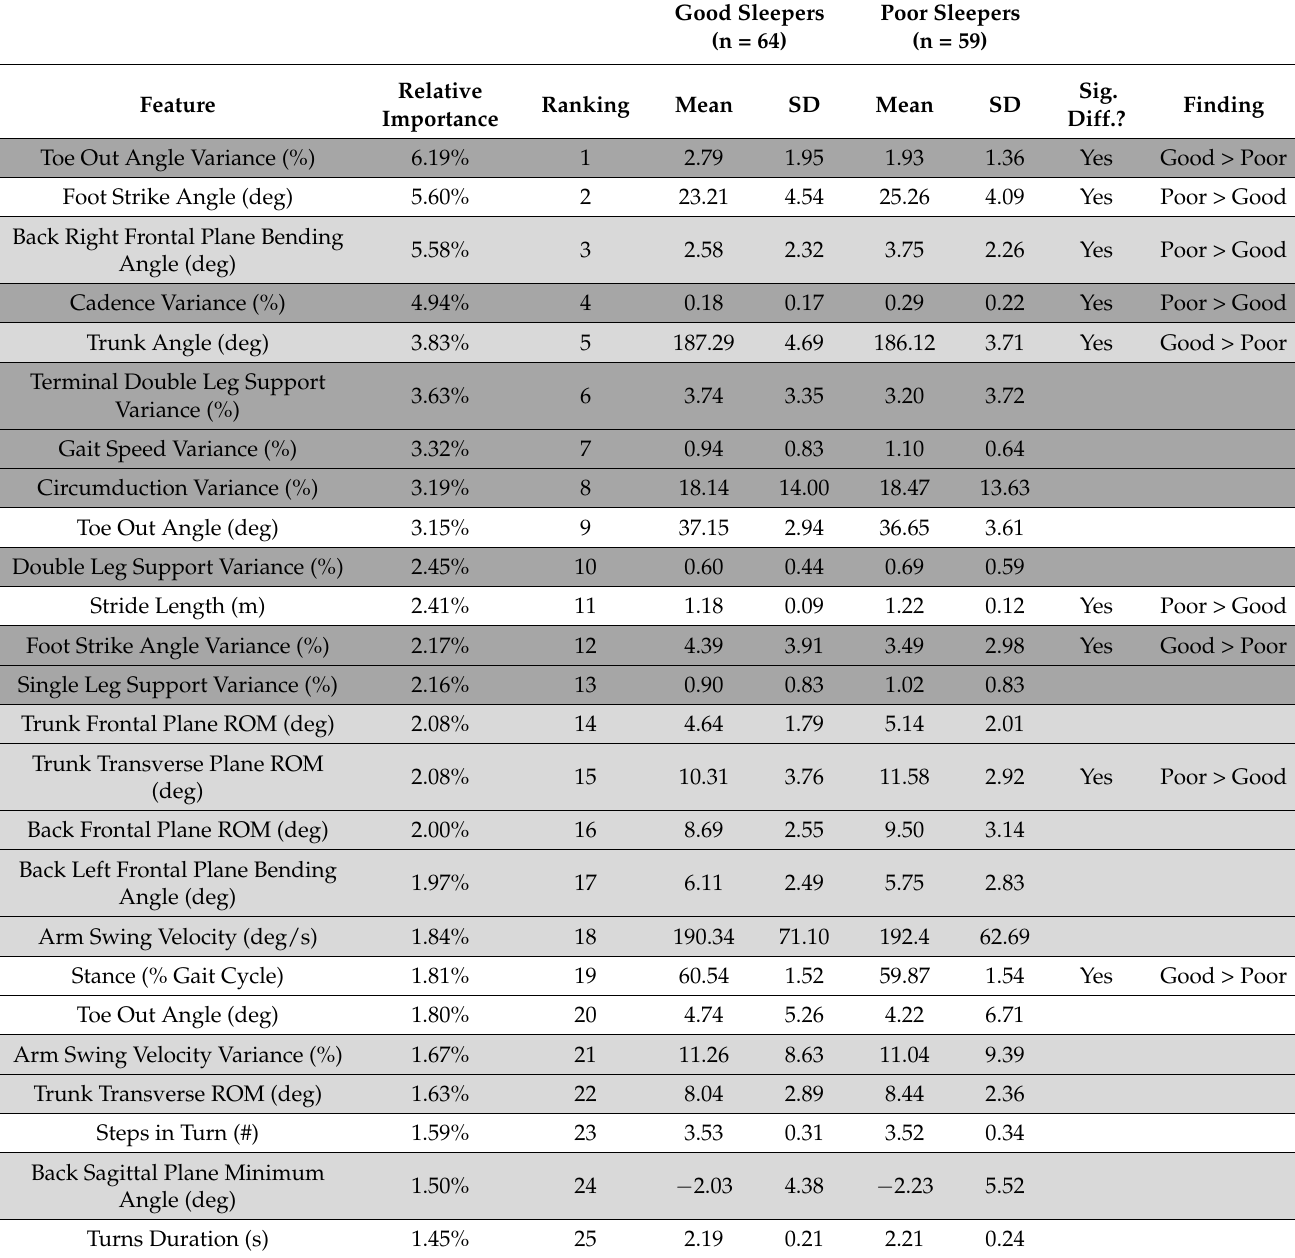
Table 2. Feature importance and descriptive